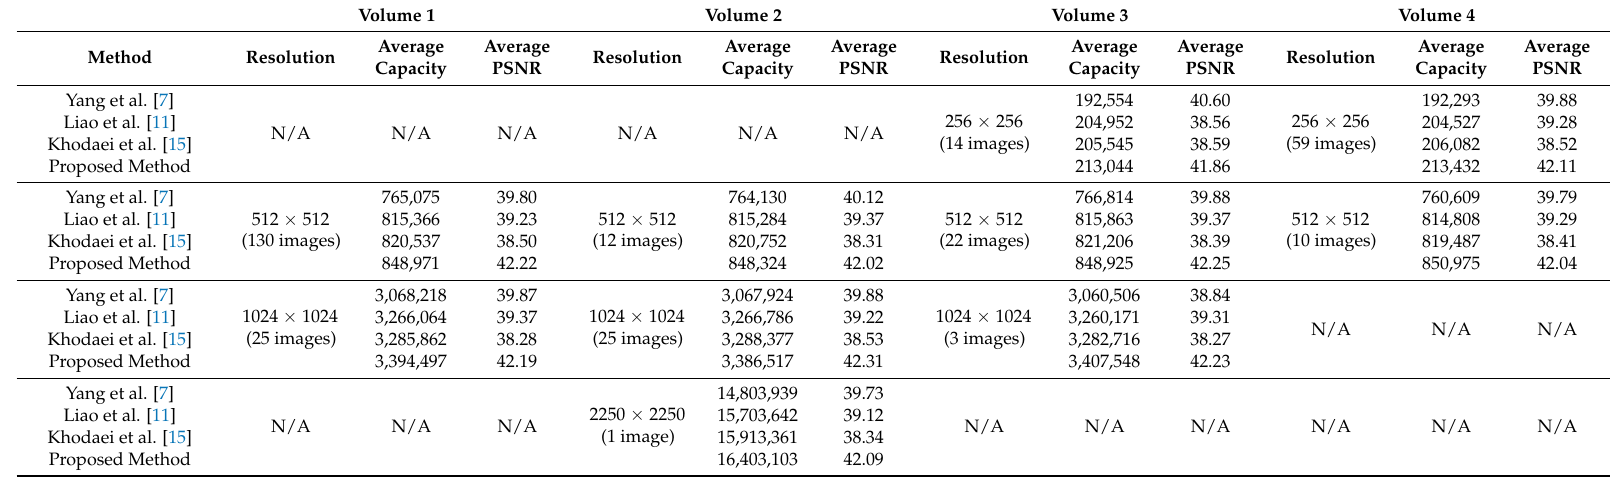
Table 5. Performance comparison using complete USC-SIPI [24] dataset of the proposed and previous